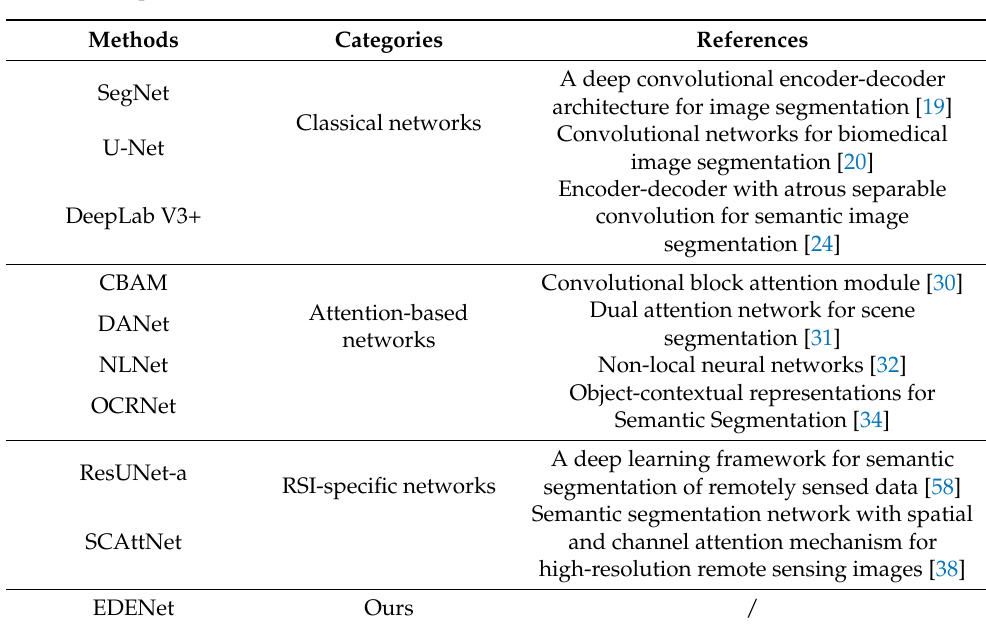
Table 3. Comparative